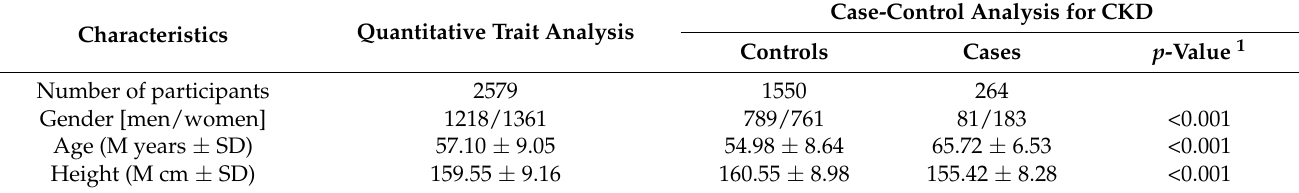
Table 1. Characteristics of participants in this